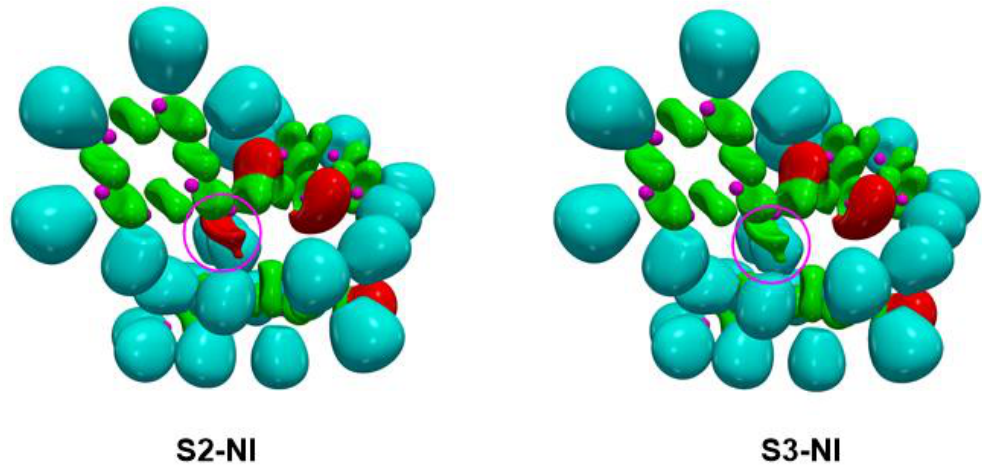
Figure 4. B3LYP / 6-31G(d) ELF localisation domains, represented at an isosurface value of ELF = 0.75, of the structures S2-NI and S3-NI involved in the formation of the first C3 − C4 single bond along the 32CA reaction between of diphenyl NI 2a and (R)-carvone 1 .